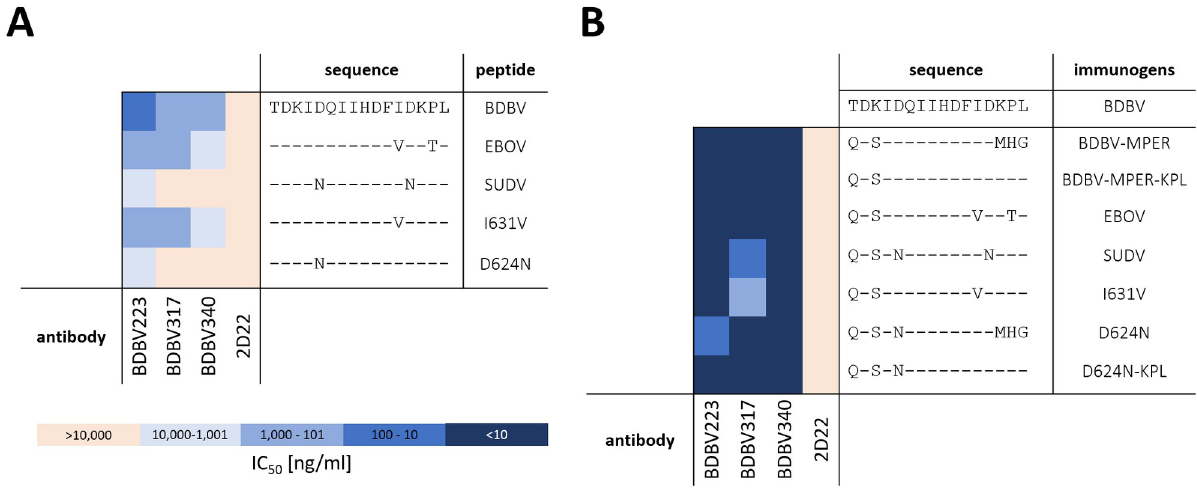
Fig 2. Antibody binding of BDBV223, BDBV317 and BDBD340 to (A) HR2-MPER peptides (data taken from Flyak et al. [14]) or to (B) designed immunogens carrying HR2-MPER sequences of BDBV, SUDV and EBOV GP or mutants to characterize sequence activity relationships. 2D22, a dengue antibody [34], was used as control for non-specific binding, in ELISA. Peptides were coated at a concentration of 4 μ g/mL, whereas immunogens were used at 1 μ g/mL, n = 2, duplicates (S1 Fig).